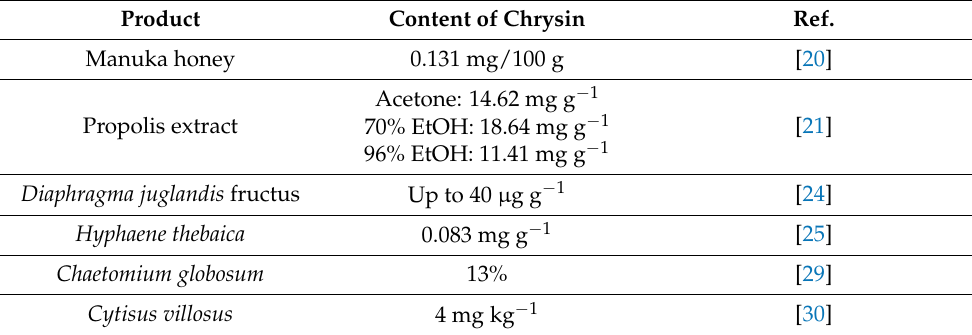
Table 1. The content of chrysin in the selected